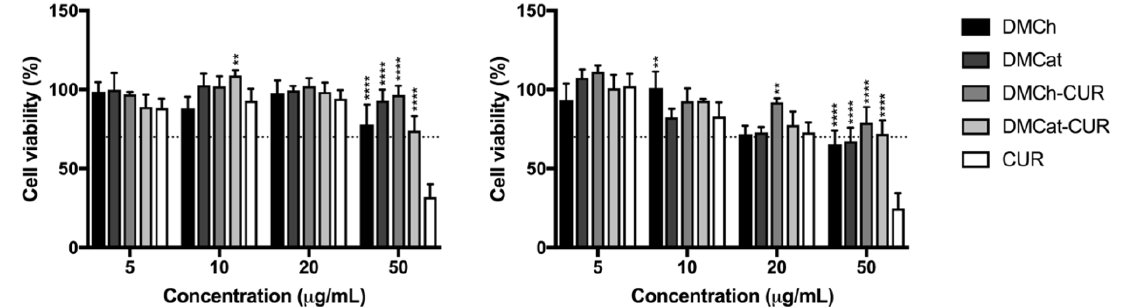
Figure 5. Cell viability of DMCh, DMCat, DMCh-CUR, DMCat-CUR, and free CUR against Caco-2 ( left ) and HT29-MTX ( right ) cell lines, respectively, at CUR concentrations between 5 and 50 µ g/mL after 4 h of incubation. Values were reported as mean ± SD ( n = 4). ** p < 0.01 and **** p < 0.0001 denotes a significant difference when compared with free CUR.